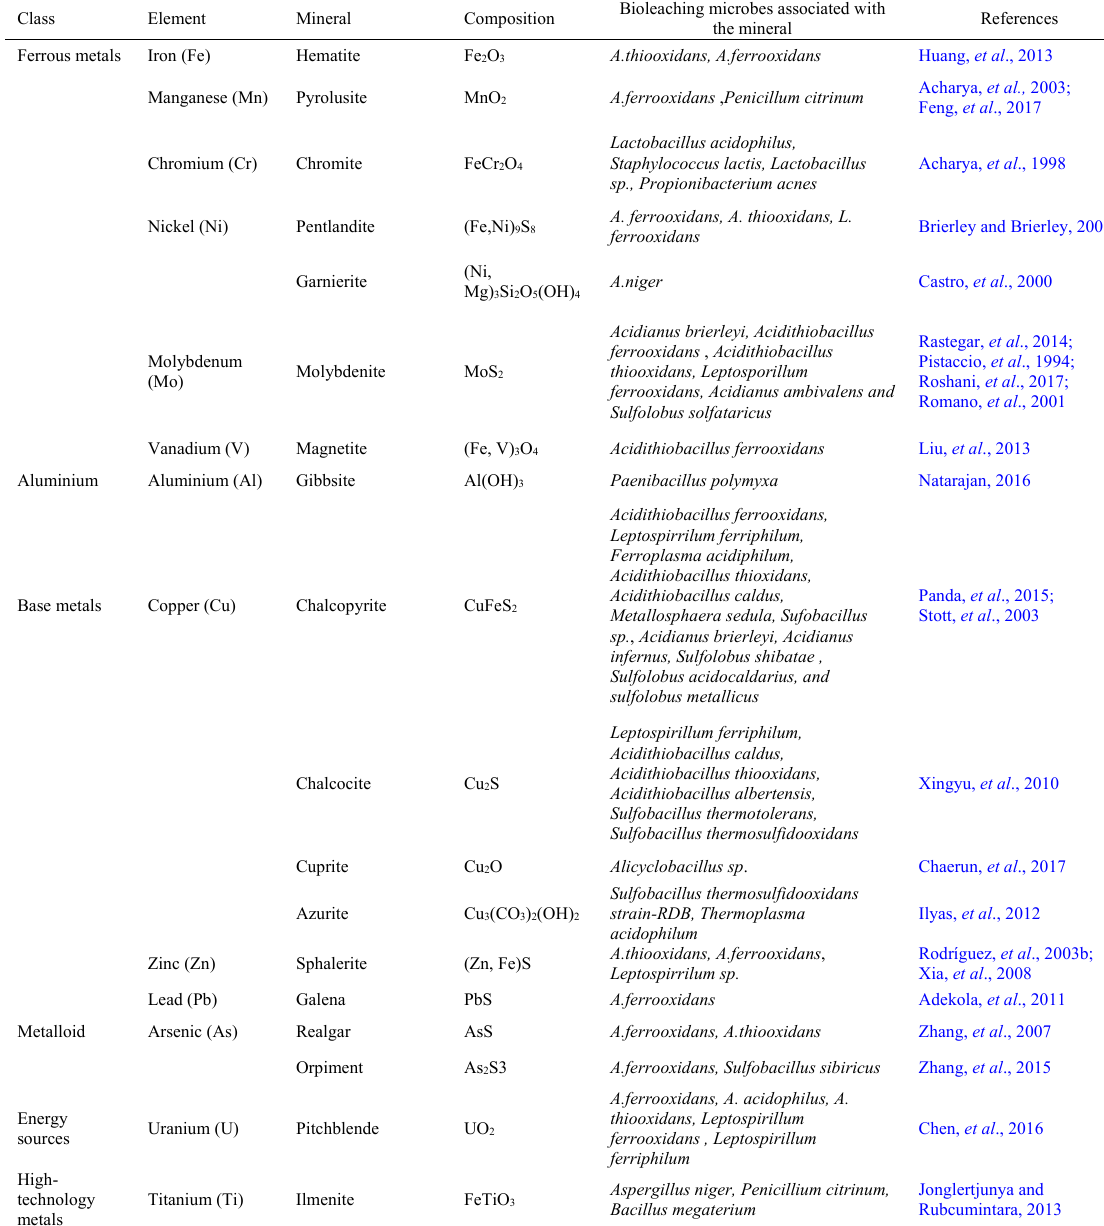
Table 1: Different minerals found in nature and bacteria associated with bioleaching (Ardnt, et al.,